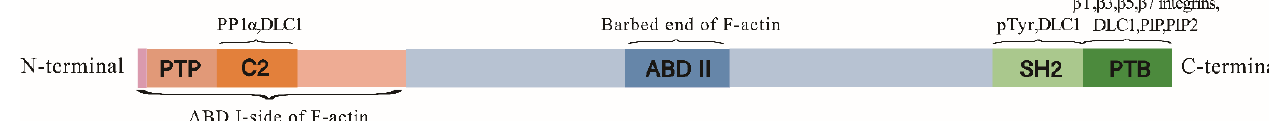
Figure 1. Domains of TNS1 and its binding